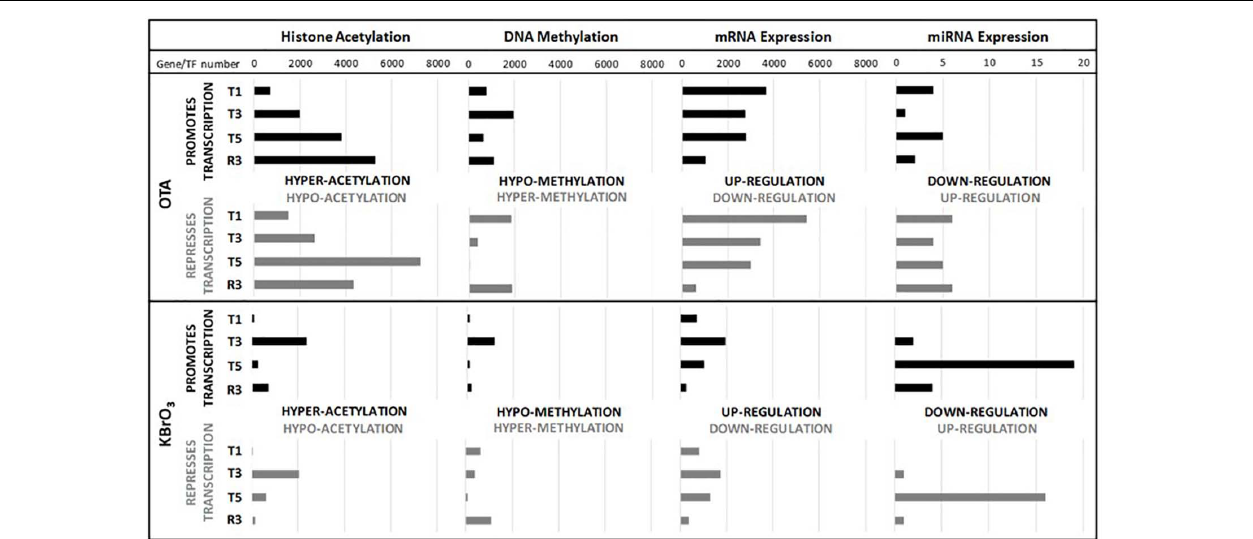
FIGURE 2 | Quantitative impact on gene expression and epigenetic modifications. The number of hypo- and hyper- acetylated histones/methylated genes was based on the sign of the difference of the median treatment and the median control values. For mRNA, the probe list was reduced per time point and treatment with a cut off on p -value of change of 0.001. When several probes for a given gene remained, the probe with the highest variation in the condition was chosen. No cut off on the intensity of change was applied. For miRNA, the probe list was reduced per time point and treatment with a p -value cut off of 0.05. For each endpoint, the number of changes is represented on the X axis and the different time points (T1, T3, T5, R3) on the Y